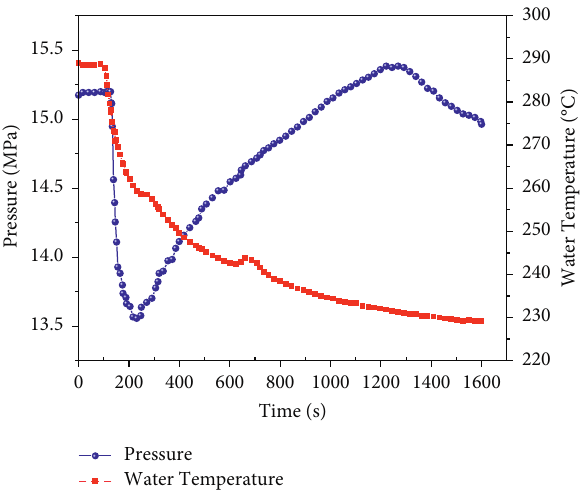
Figure 2: The temperature and pressure histories during PTS transient